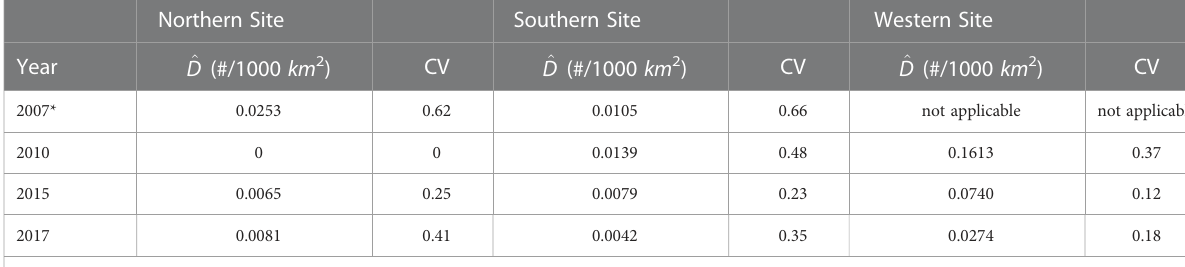
TABLE 7 Estimated average density of Gervais ’ beaked whales and associated CV obtained by the bootstrap